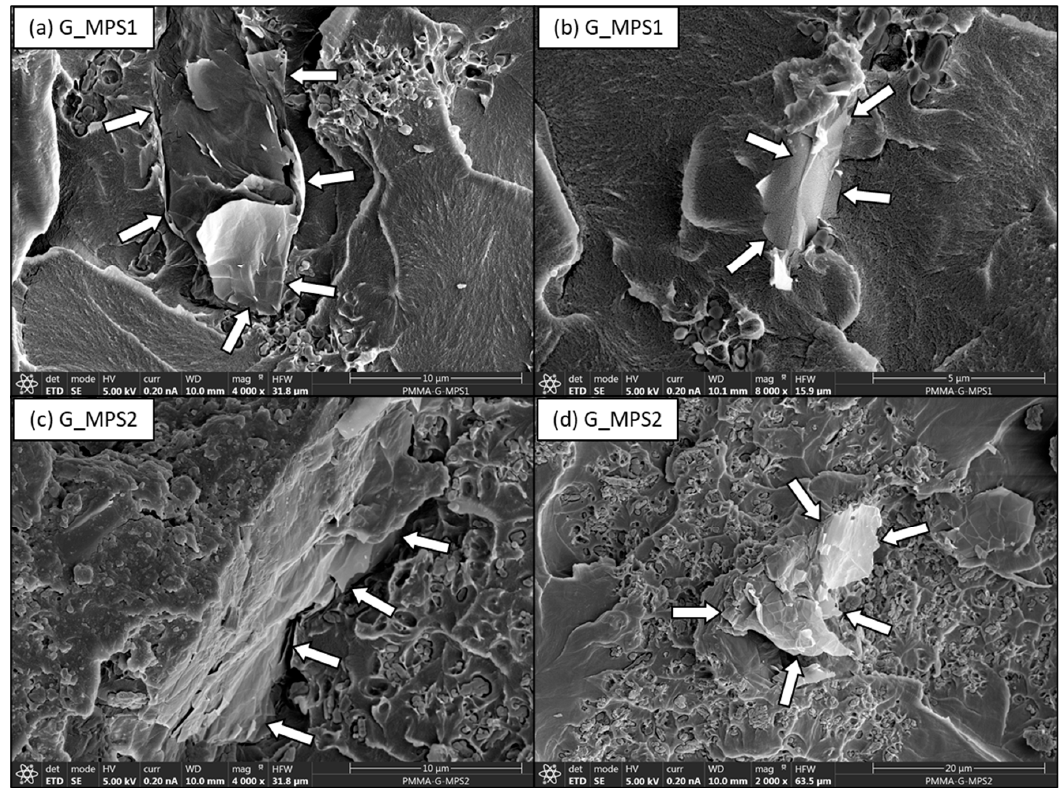
Figure 7. SEM micrographs of bone cement with G_MPS1 at 4000× ( a ) and 8000× ( b ) magnification; and G_MPS2 at 4000× ( c ) and 2000× ( d ) magnification, showing regions with G sheets.